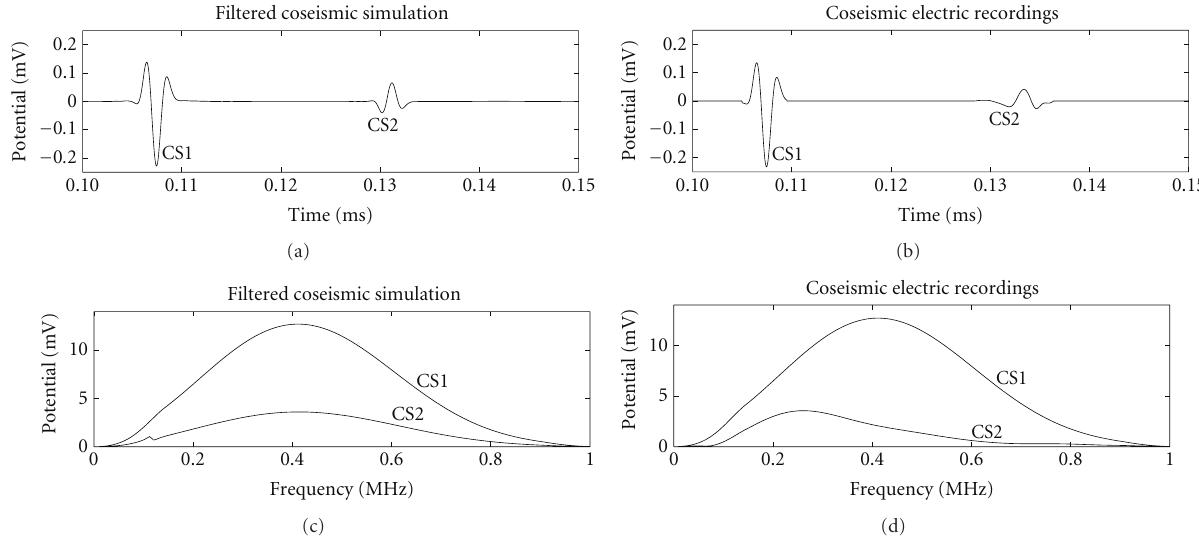
Figure 11: Model of filtered coseismic responses in time (a) and frequency domain (c) and coseismic measurements in time (b) and frequency domain (d). Pulse abbreviations are: coseismic response 1 (CS1) and coseismic response 2